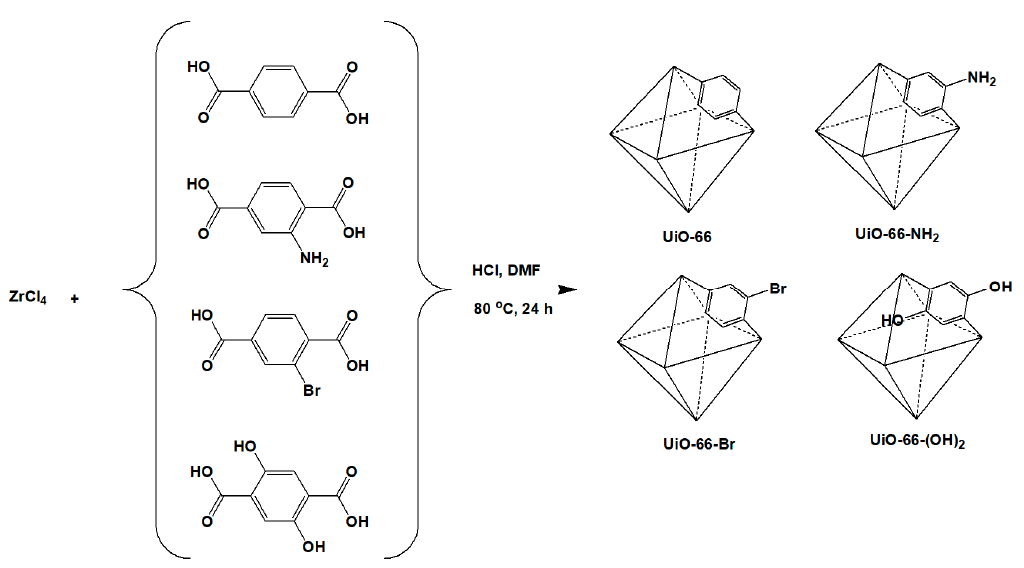
Figure 1. Synthesis scheme of nanocrystalline UiO-66 and its derivatives.